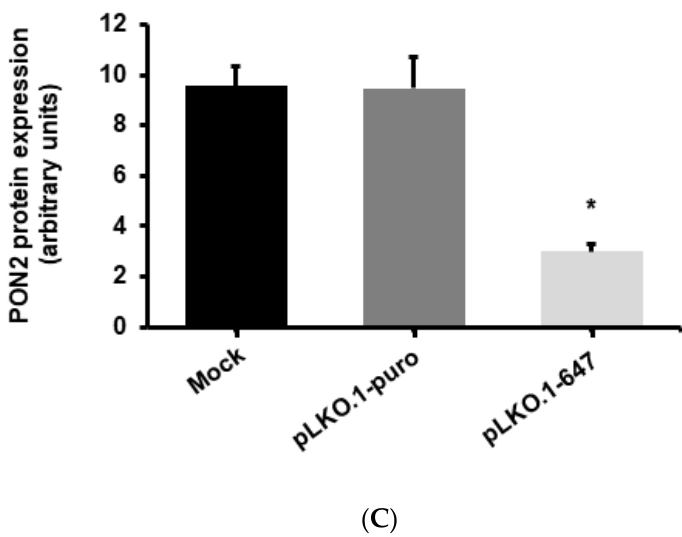
Figure 1. Evaluation of PON2 silencing. A375 cells were treated with a shRNA-coding plasmid against PON2 (pLKO.1-647), with empty vector (pLKO.1-puro), or with transfection reagent only (mock). PON2 expression was evaluated at mRNA and protein level by Real-Time PCR (panel A ) and Western blot (panels B and C ). Values are expressed as mean ± standard deviation (* p < 0.05).